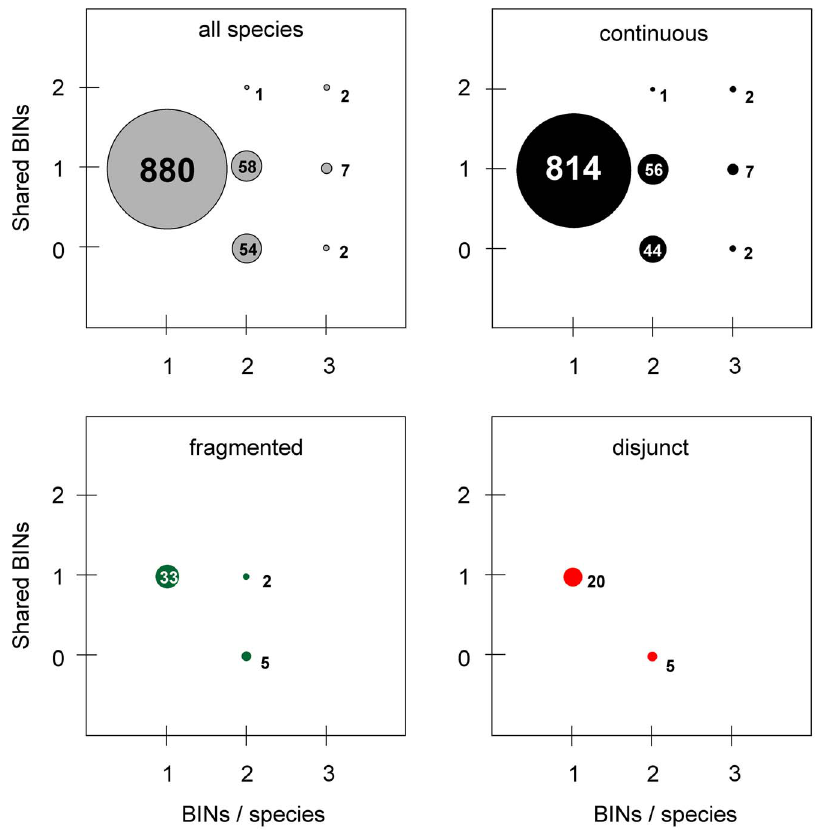
Fig. 11. BIN assignment in relation to species taxonomy and distribution category. Circles represent species assigned to one, two or three BINs, of which none, one or two are shared between Finland and Austria. Circle area is proportional to the number of species (number in or beside circle). BIN assignments are shown for all species, and separately for different distribution types. The 12 migratory species were each assigned to one BIN per species (not